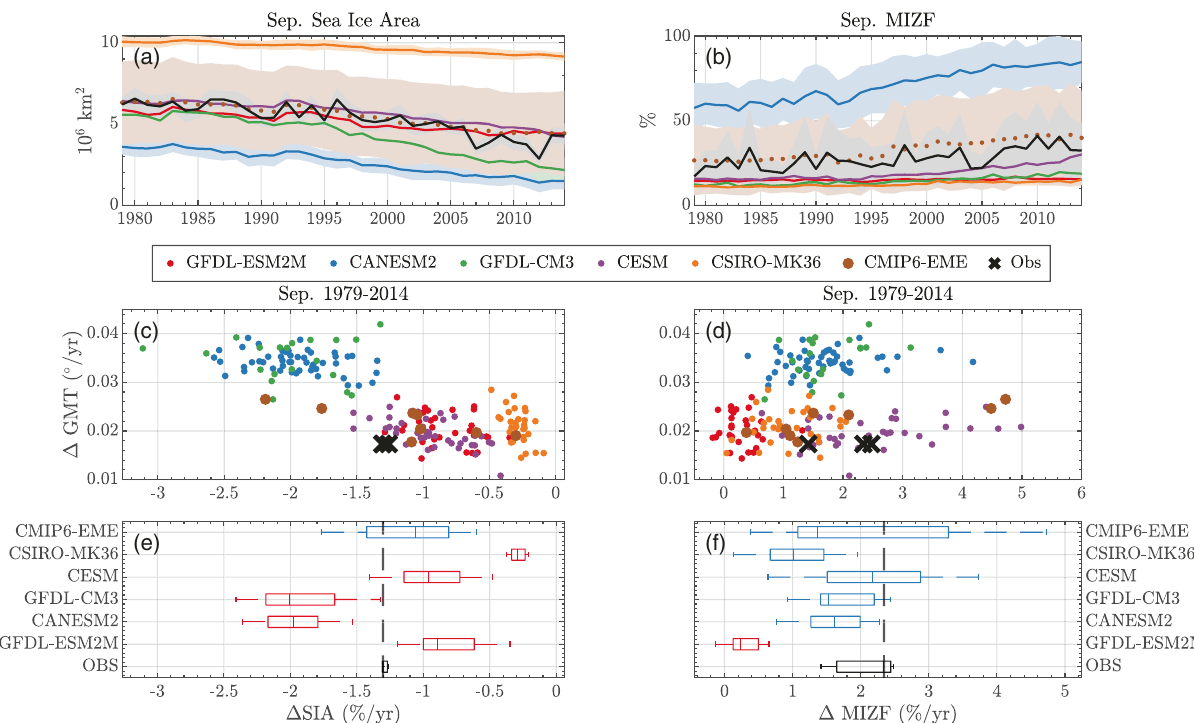
Fig. 1 September sea ice statistics, sensitivities, and trends. a Annually averaged SIA for all CLIVAR-LE and CMIP6-EME simulations. Solid lines are CLIVAR-LE ensemble means. Dotted line is the CMIP6-EME ensemble mean. Colored areas are one unbiased sample standard deviation from ensemble means (see “ Methods ” ). Black lines and shaded region is the same for observations and observational uncertainty. c Scatter plot of 1979 – 2014 trend in global mean temperature vs normalized trend in sea-ice area (expressed as a percentage per year). Crosses are observations. e Box plots of sea-ice area trends for models shown above and observations. Whiskers extend the boxes ± 3 standard deviations from the mean in each month and vertical line is ensemble median. Dashed black line extends the median observed trend. Blue boxes are plausible estimates given the observation (black boxes, see methods), red boxes are implausible estimates (at p = 0.01). b , d , f Same as ( e ) but for MIZF.